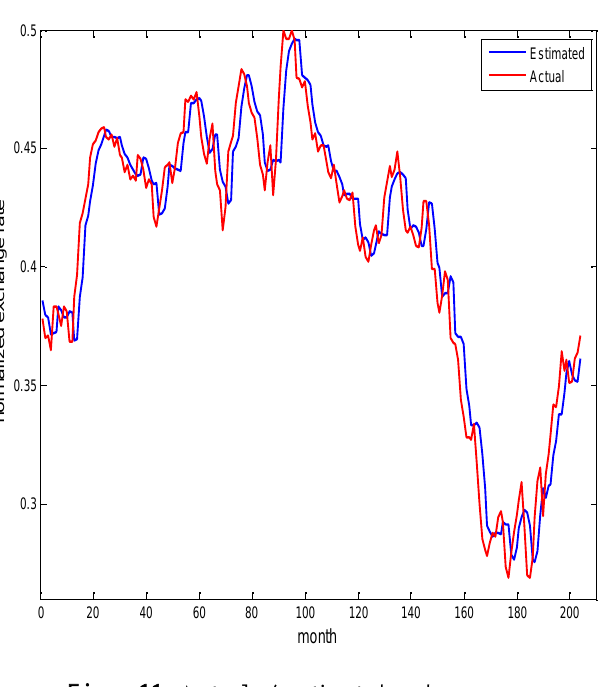
Figure 11 . Actual v/s estimated exchange rate prices for Euro/Dollar by combined method (error based)